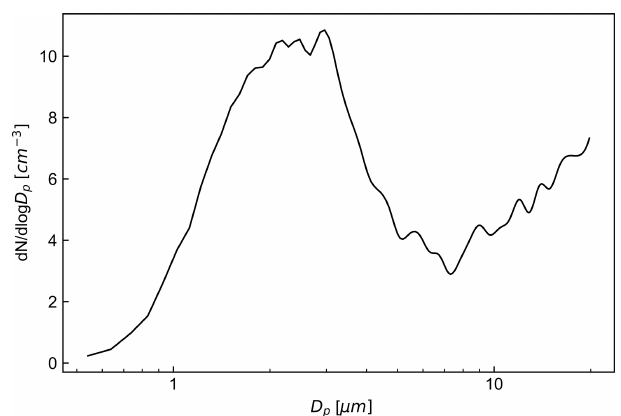
Figure 3. Number concentration as a function of the aerodynamic particle diameter of soda lime glass microspheres used for L-PCVI and SPIDER validation experiments.